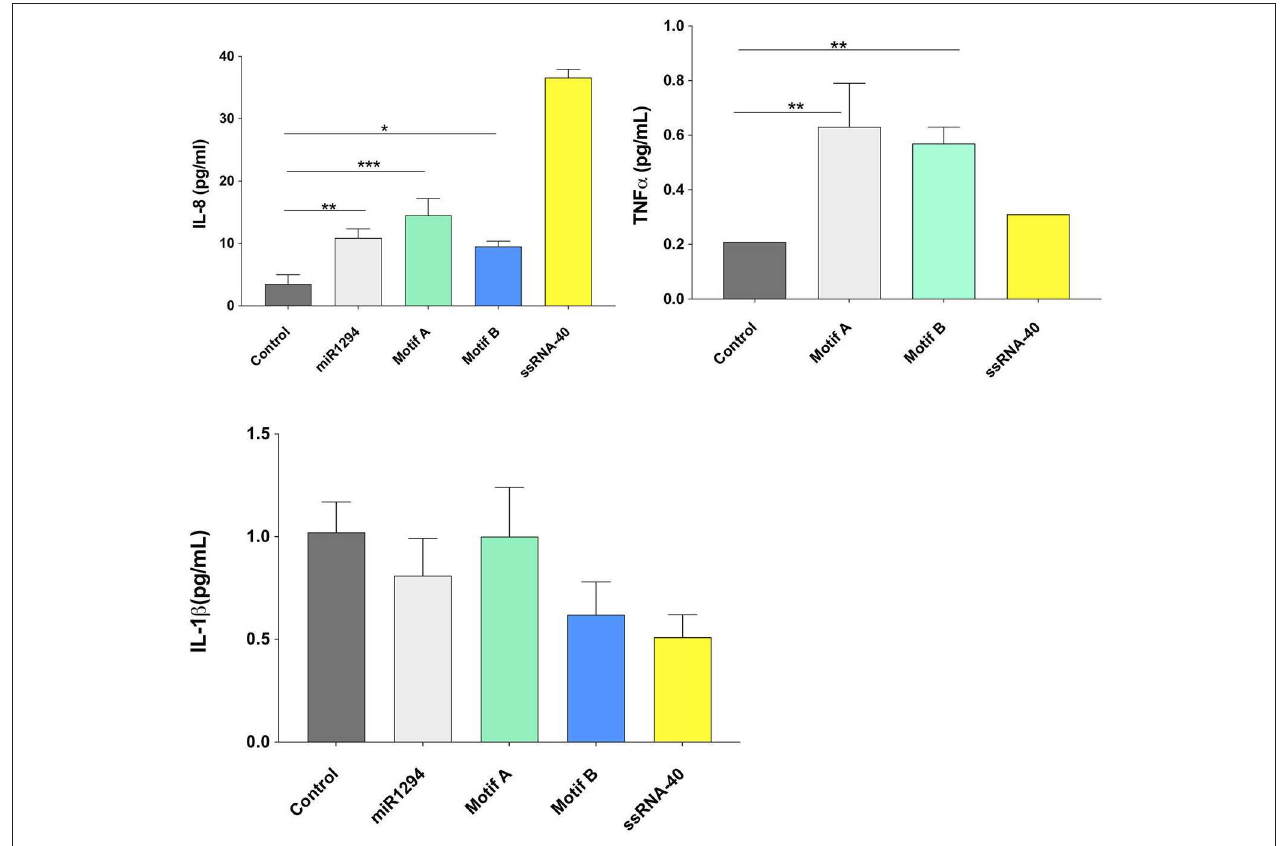
FIGURE 3 | miR-1294 and its core motifs induce expression of IL-8 and TNF α but not IL-1 β protein. HEK-Blue TM hTLR8 cells (Invivogen, San Diego, CA), were incubated with miR-1294 mimic and its two core motifs (Motif A-AUUGUUG and Motif B- AUUGUUA) for 24h. Supernatants were collected and assayed for levels